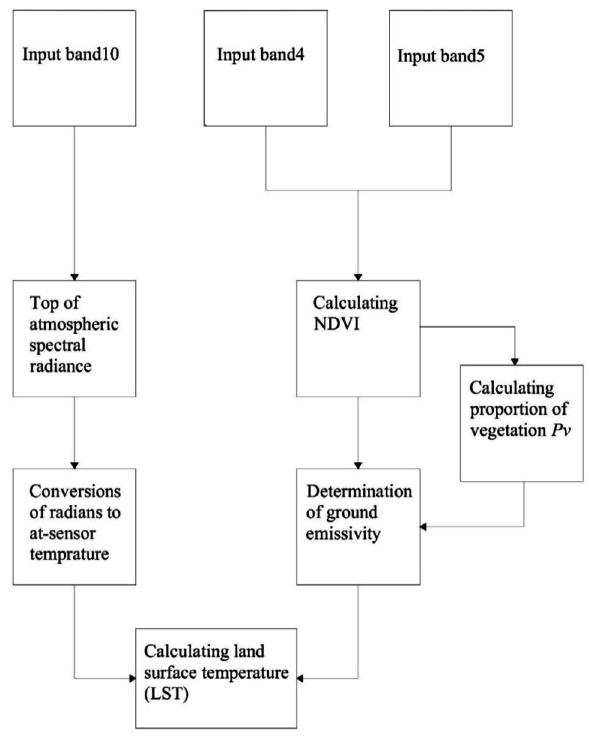
Figure 15. The schematic algorithm of Arc GIS package program.